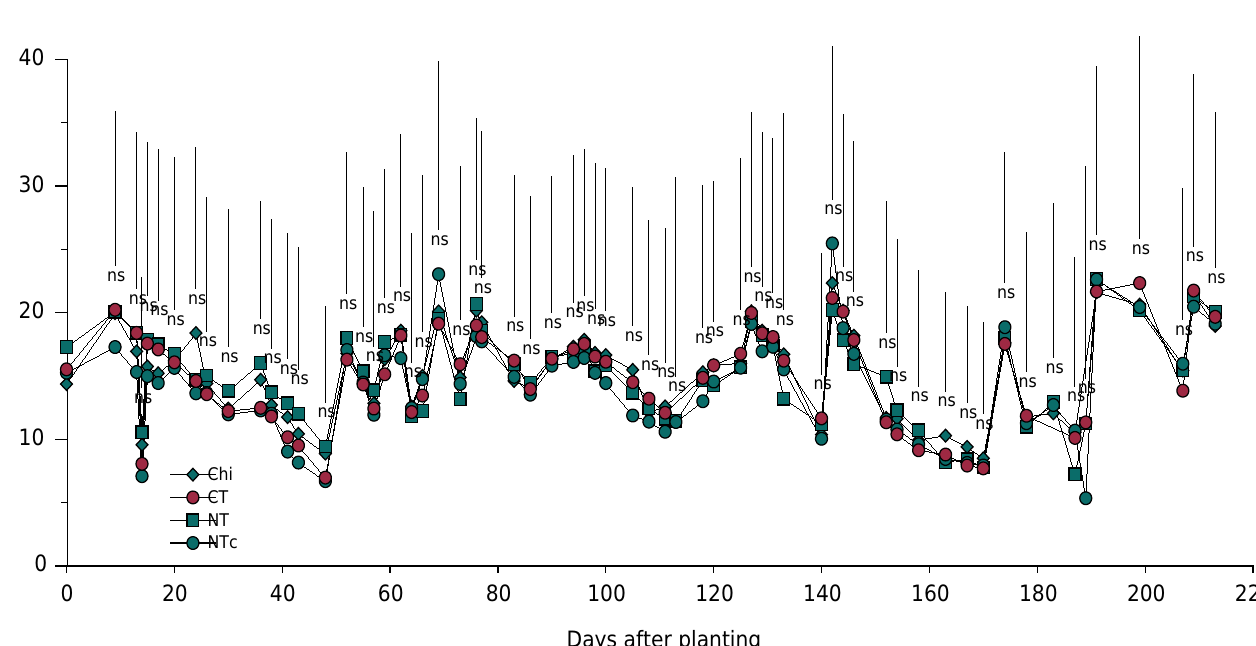
Figure 6. Available water in the 0.00-0.40 m layer, for chisel plough (Chi), conventional tillage (CT), no-tillage (NT), and compacted no-tillage (NT C ), in three soil layers, during cassava growth. ns: not significant (DMS test, 5 % probability level).